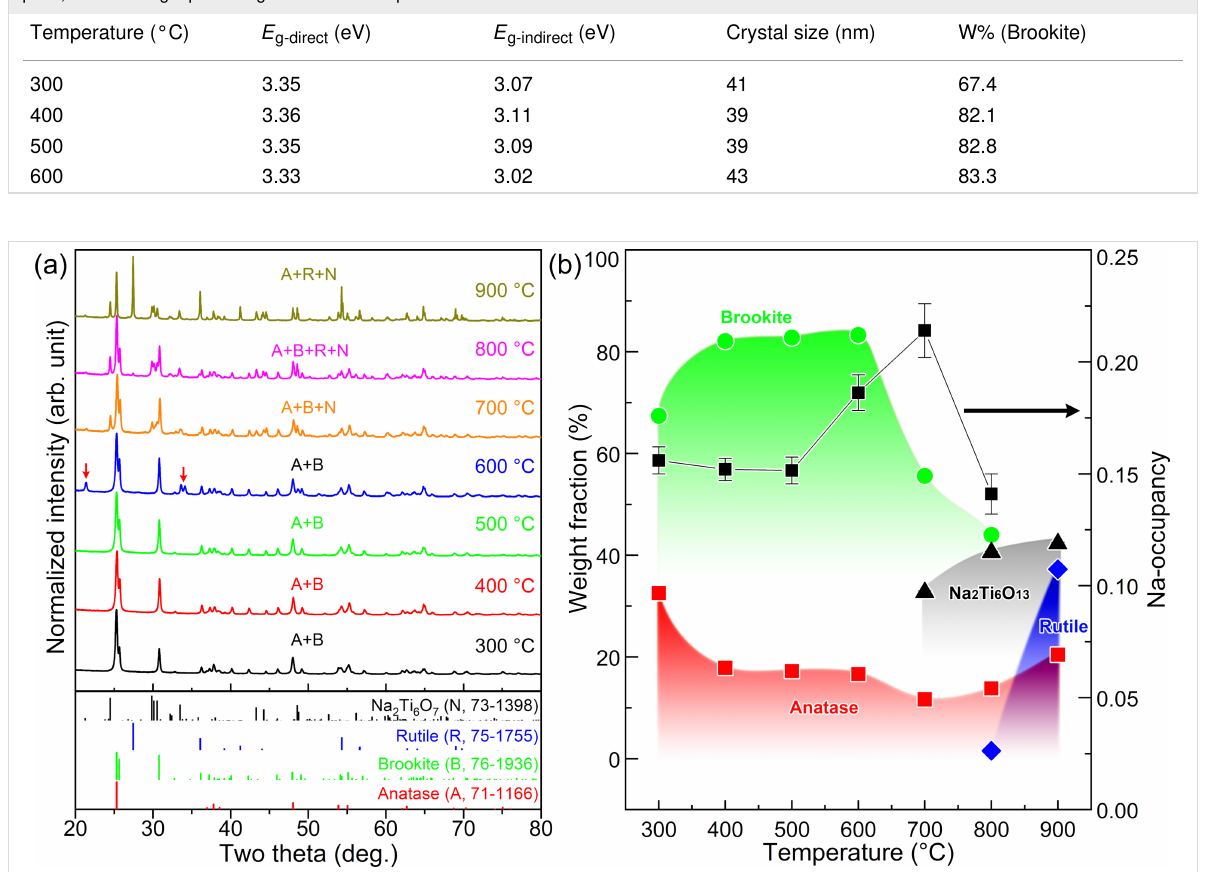
Figure 3: (a) The powder X-ray diffraction patterns of samples calcinated at 300–900 °C for 2 h, where the arrows indicate peaks of Na 2 CO 3 . (b) The temperature dependence of weight fractions and Na occupancy in the brookite phase.